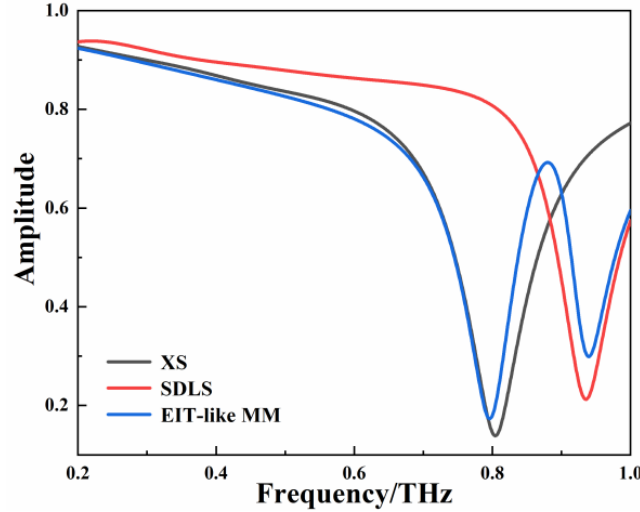
Figure 2. Transmission-amplitude curves of XS, SDLS, and EIT-like MM.